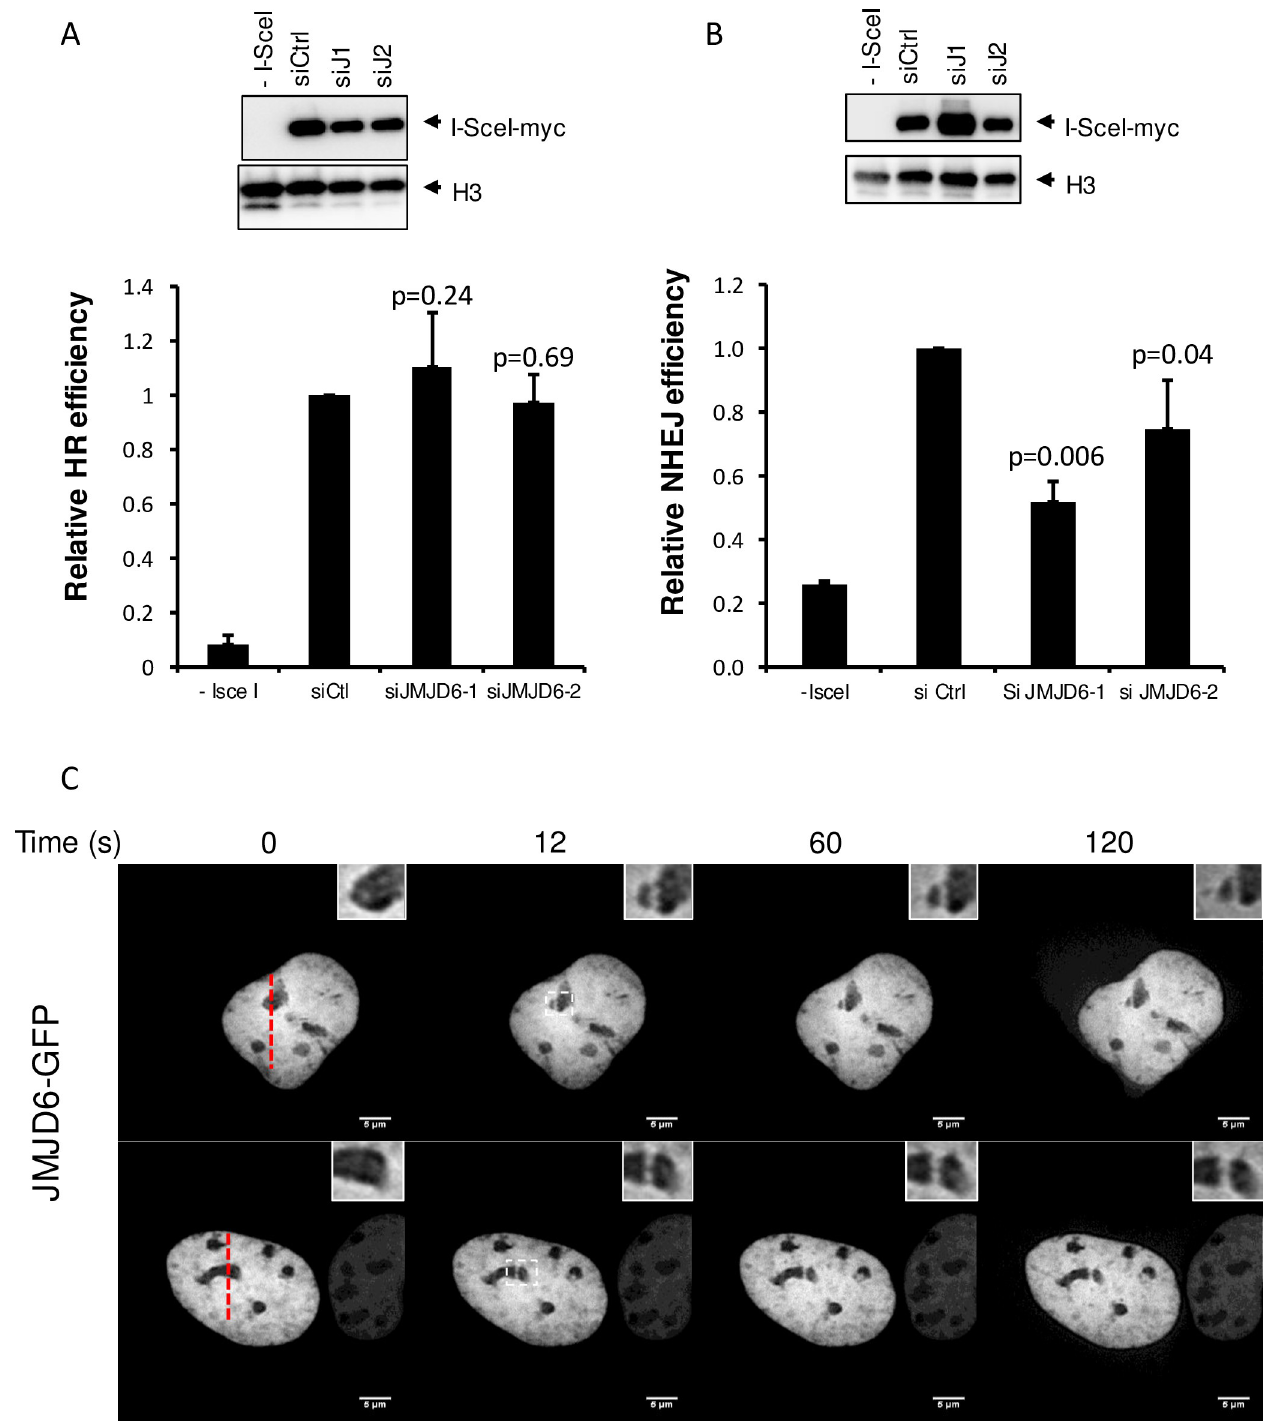
Fig 2. DSB repair using NHEJ is affected by JMJD6 depletion. (A) Relative frequency of Homology-Driven Repair of DSB in JMJD6 depleted cells. the percentage of GFP positive cells was measured by flow cytometry and calculated relative to 1 in cells transfected by the control siRNA. The mean and standard deviation from four entirely independent experiments are shown. The right panel shows a Western blot monitoring I-SceI expression in the different transfected cells. (B) Same as in A except that GCS5 human fibroblasts containing a reporter system for NHEJ were used. The p values of the difference to the control siRNA are indicated (Student t test). (C) U2OS cells transfected by a plasmid expressing JMJD6-GFP fusion protein and subjected to local laser irradiation 24h later. Images of cells before and after the indicated time following nucleus laser irradiation are shown. The red dashed lines represent the laser irradiated region in the nucleus. insert: magnification of the nucleolus irradiated regions. Scale bar 5 μ m. https://doi.org/10.1371/journal.pgen.1008511.g002 PLOS Genetics | https://doi.org/10.1371/journal.pgen.1008511 June 29,